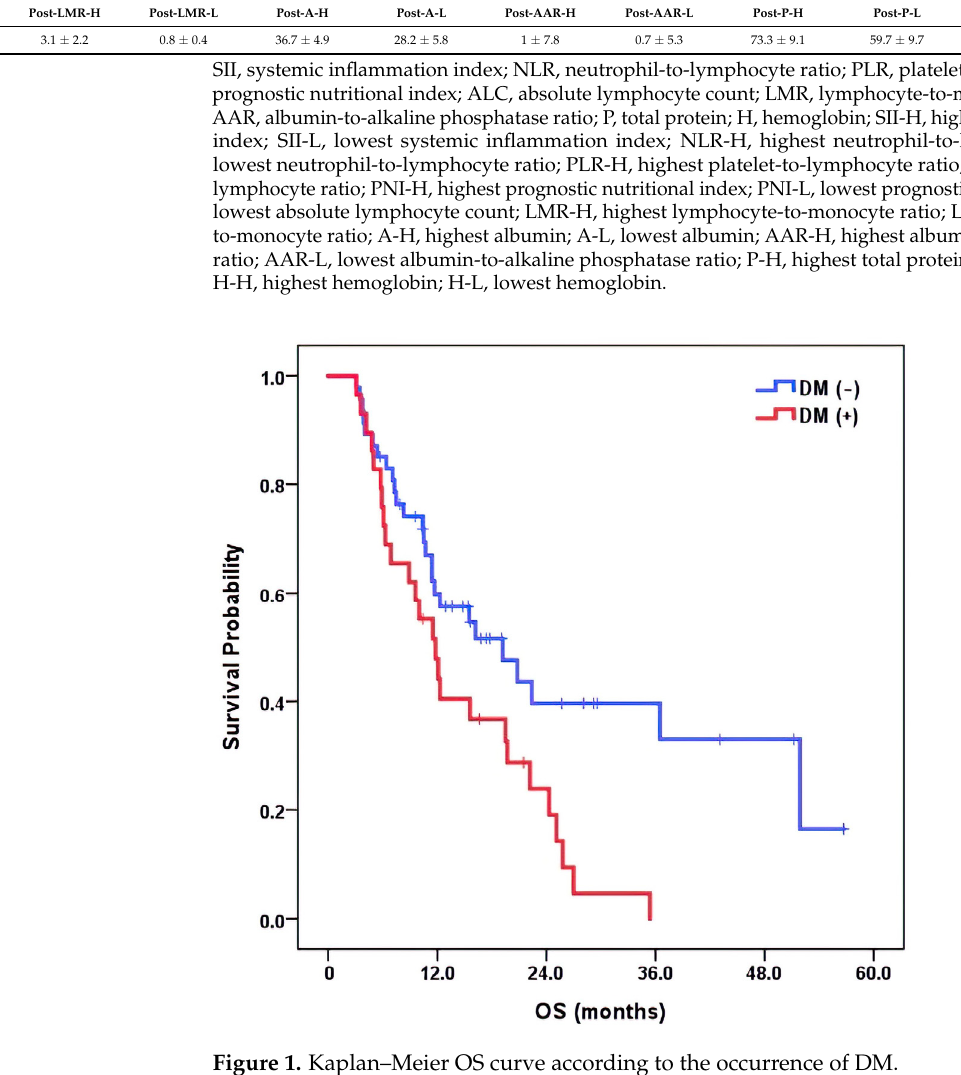
Figure 1. Kaplan–Meier OS curve according to the occurrence of Figure 1. Kaplan ‒ Meier OS curve according to the occurrence of DM.